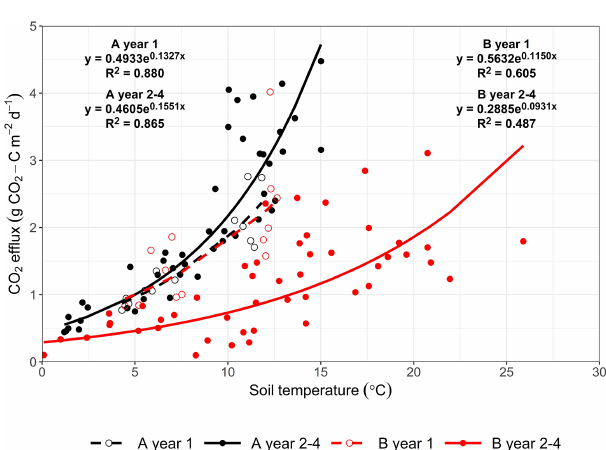
Figure 4. Exponential relationship between soil CO 2 effluxes and soil temperature at 2cm depth measured from area A (mature spruce stand; black) and area B (clear-fell site; red) before (dashed lines; year 1) and after (solid lines; years 2–4) felling. Equations and R 2 for fitted lines